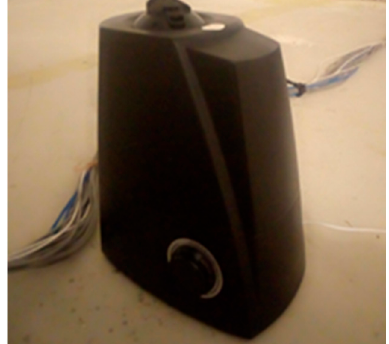
Figure 13. 6 litres Ultrasonic Humidifier.